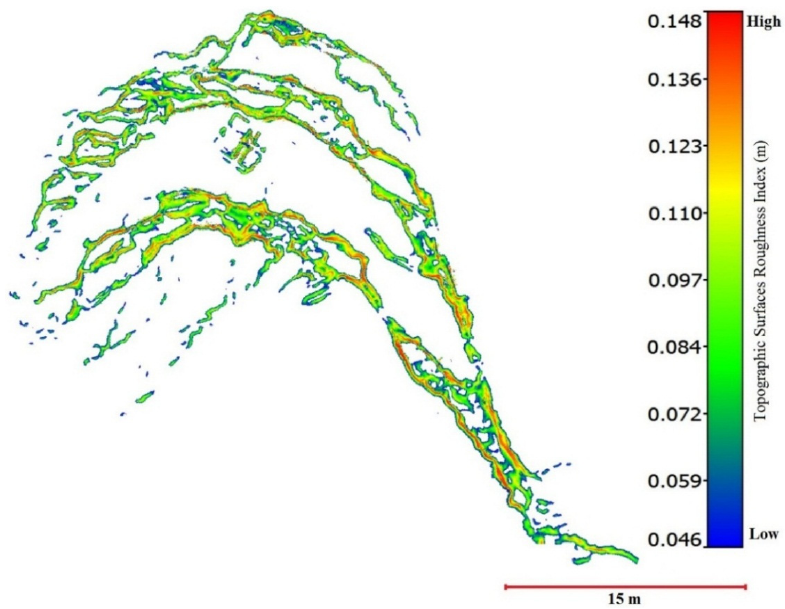
Figure 24. Extraction of landslide scarp features of the Salhoub/Al-Juaidieh landslide based on local topographic surface roughness values.